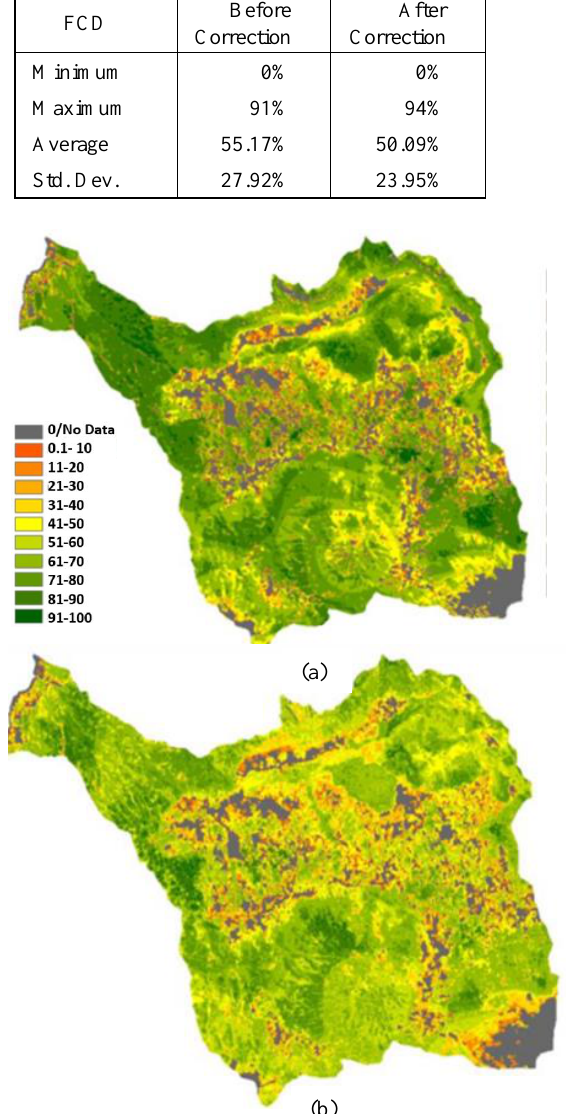
Figure 11. FCD value, (a) before and (b) after topographic correction